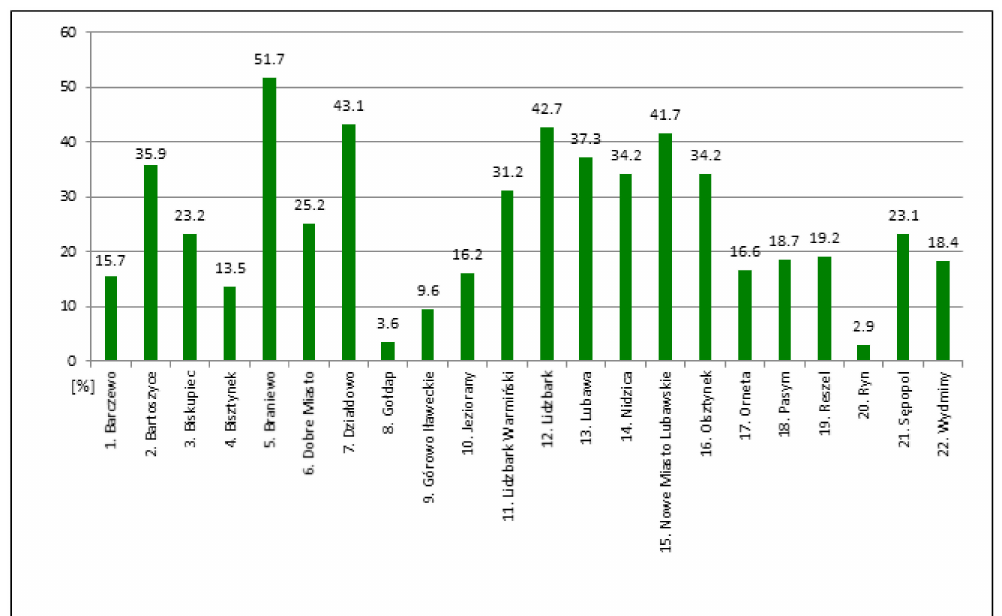
Figure 10. Increase in the developed area of Polish towns. Source: own